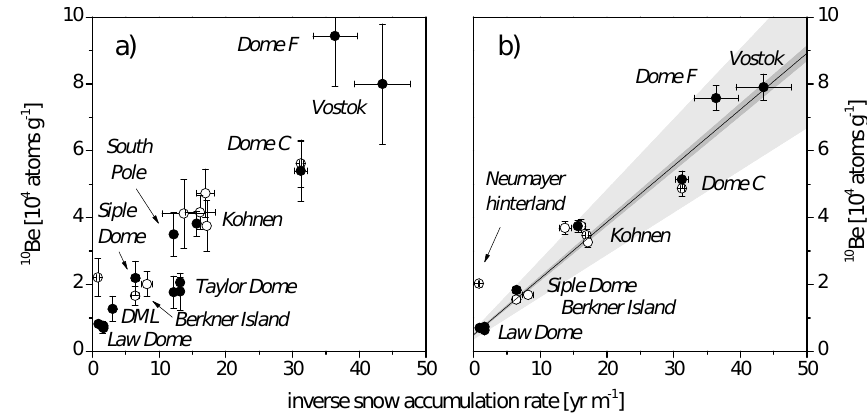
Figure 4. Mean 10 Be ice concentrations from various sites in Antarctica plotted against corresponding (inverse) snow accumulation rates (given in water equivalent). Filled dots refer to published data while open circles represent unpublished data. (a) Originally published values without any correction. Error bars denote the standard deviation of the respective time series. (b) Mean 10 Be concentrations corrected for different time coverage and AMS measurement standards (see Sect. 2.2 for details). Here, error bars show an average AMS uncertainty of 5%. Note that, different to (a) , 10 Be data sets which lack information on the AMS calibration standard used for measurements are disregarded. The straight line denotes a linear fit to the data and the dark grey shaded area depicts the formal fitting error. Light grey shaded area is based on 25% higher and lower slope (and y intercept) and covers all data points (except two outliers: 12% of total number). Data: Raisbeck et al. (1990); Steig (1996); Aldahan et al. (1998); Smith et al. (2000); Nishiizumi and Finkel (2007); Horiuchi et al. (2008); Baroni et al. (2011); Pedro et al. (2012); Steinhilber et al. (2012). Further accumulation rate data: Jouzel et al. (1979); Sommer et al. (2000); Hamilton (2002); Pourchet et al. (2003); Oerter et al. (2004); Fernandoy et al. (2010).